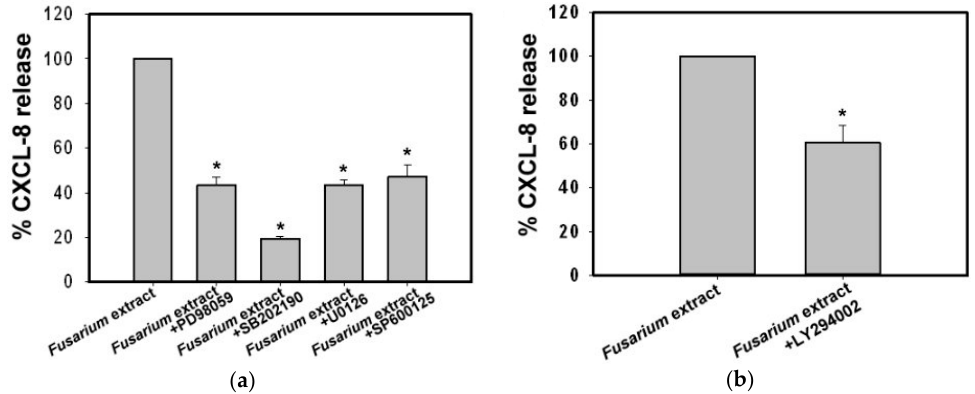
Figure 5. Effects of mitogen-activated protein kinases (MAPKs) and phosphoinositide 3-kinase (PI3K) inhibitor on CXCL-8 release by F. proliferatum -stimulated BEAS-2B cells. BEAS-2B cells were